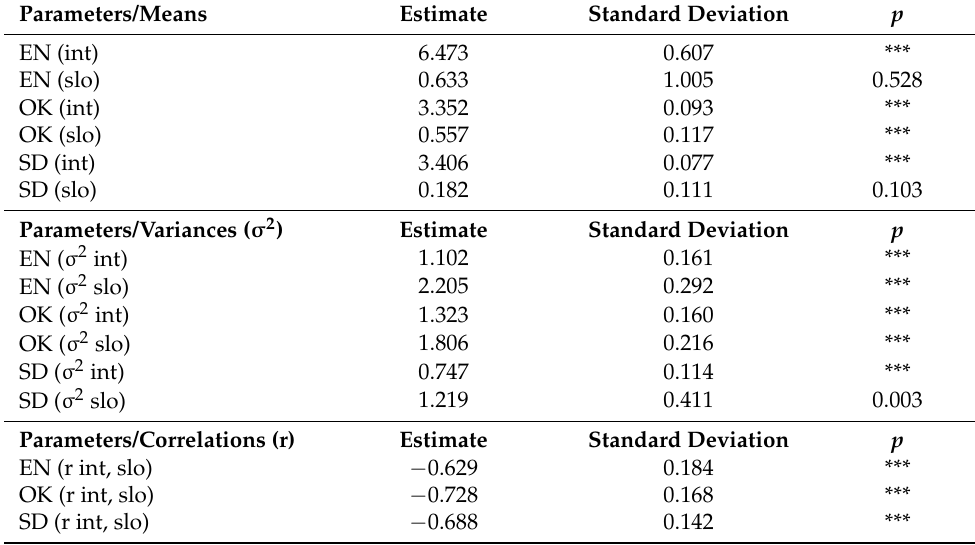
Table 4. LGM estimated